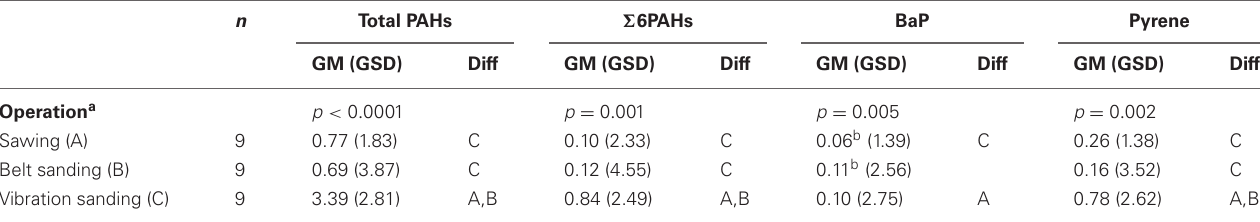
Table 2 | Total PAHs, (cid:2) 6PAHs, BaP, and pyrene concentrations (ppm) measured in dust collected in the experimental chamber by wood type and